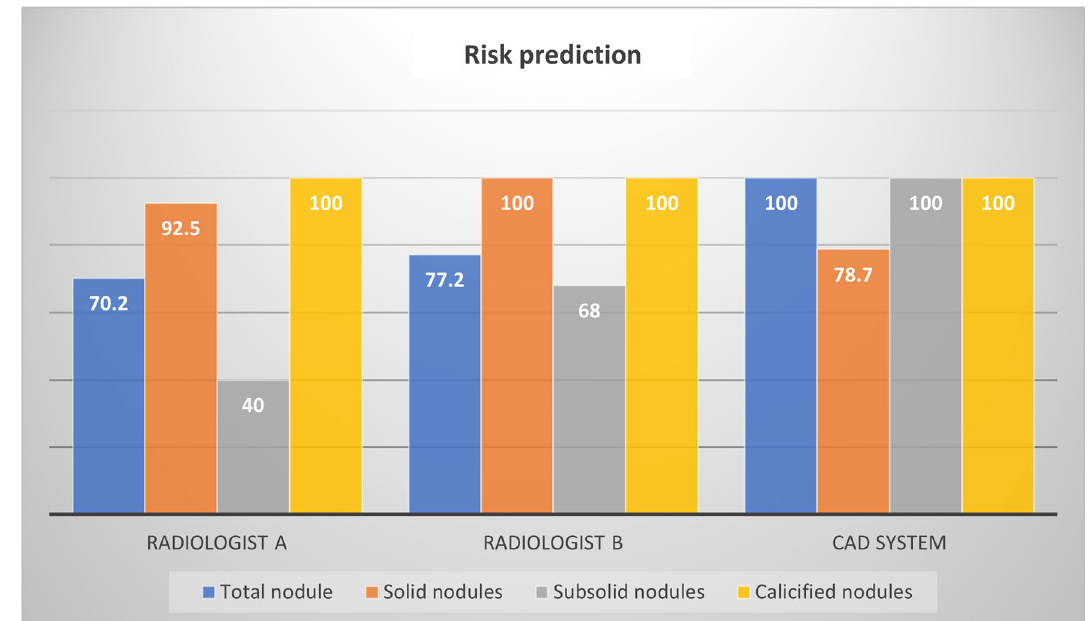
Fig. 6 Accuracy of risk prediction (in %) between radiologist A, radiologist B and CAD system in lesions with different